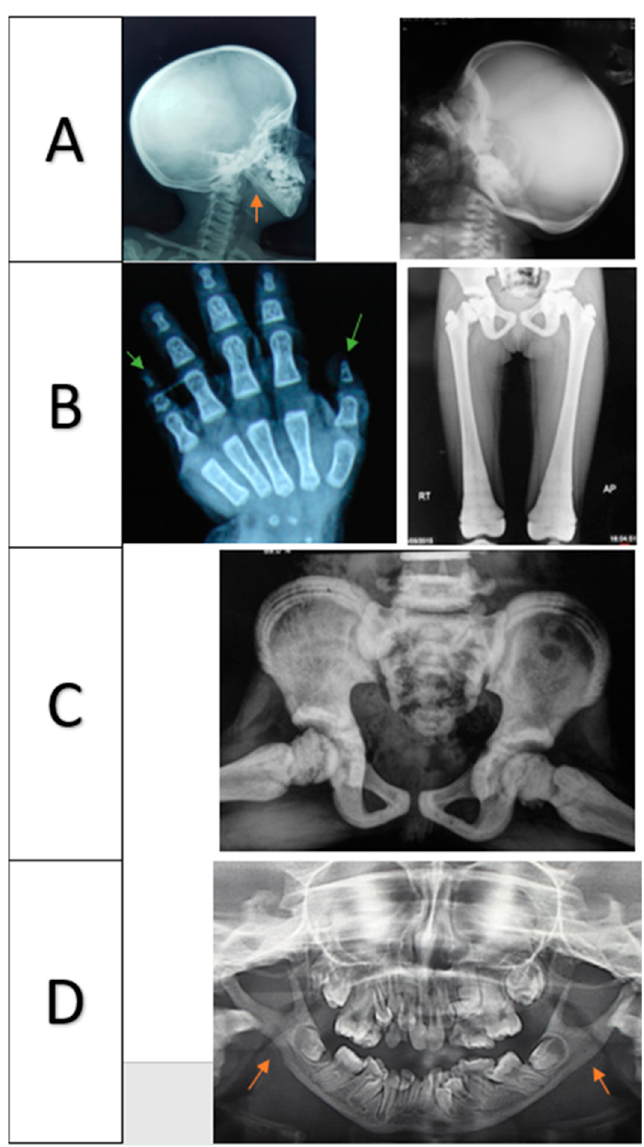
Figure 2. ( A ) Skull showing thick calvarium, open anterior fontanelle, and wormian bones; red arrows indicate straight mandibular angles. ( B , C ) Increased bone density; green arrows indicate acro-osteolysis of terminal phalanges. ( D ) Panorama X-rays showing crowding of the teeth; red arrows indicate straight mandibular angles.